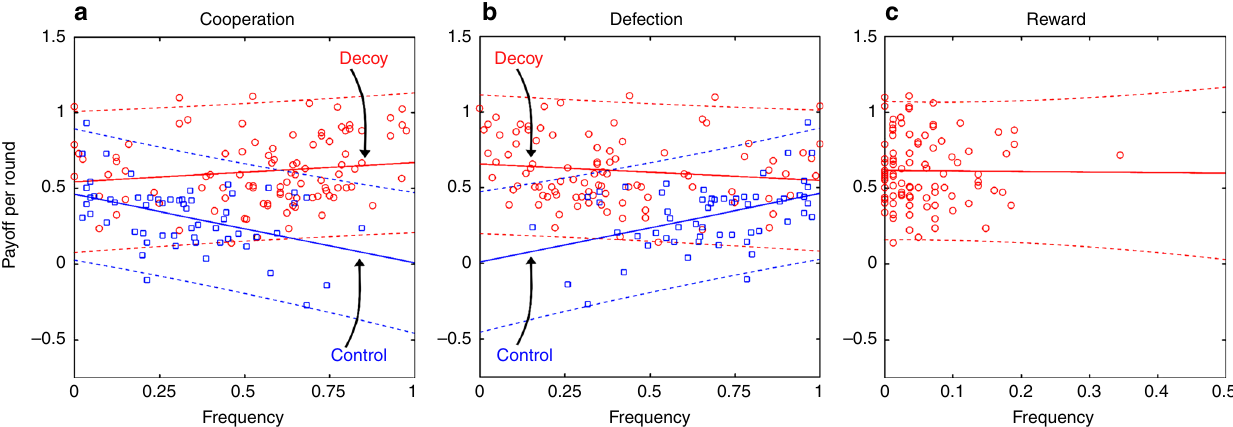
Fig. 5 Reward improves the likelihood of success for cooperators. a In the control treatment, per-round payoff correlates negatively with cooperation frequency (intercept 0.459, 95% con fi dence interval [0.369 – 0.549]; slope − 0.452, 95% con fi dence interval [ − 0.691 to − 0.212]; coef fi cient of determination R 2 = 0.197). This negative correlation disappears in the decoy treatment (intercept 0.541, 95% con fi dence interval [0.431 – 0.650]; slope 0.128, 95% con fi dence interval [ − 0.0511 to 0.306]; coef fi cient of determination R 2 = 0.0205). In fact, the angle between the two lines is signi fi cantly positive ( F -test for the treatment × frequency interaction; F -statistic 13.2; p value 0.0004), indicating that the decoy ’ s presence improves the likelihood of success for cooperators. b Because frequencies of cooperation and defection in the control treatment sum to unity, regression lines for cooperation and defection in this treatment must exhibit a mirror symmetry (intercept 0.0075, 95% con fi dence interval [ − 0.164 to 0.179]; slope 0.452, 95% con fi dence interval [0.212 – 0.691]; coef fi cient of determination R 2 = 0.197; cf. panel ( a )). Although the same symmetry need not hold in the decoy treatment due to reward, regression lines for cooperation and defection are also almost an ideal mirror image of one another (intercept 0.654, 95% con fi dence interval [0.575 – 0.733]; slope − 0.109, 95% con fi dence interval [ − 0.276 to 0.0577]; coef fi cient of determination R 2 = 0.0173; cf. panel ( a )), indicting that reward worsens the likelihood of success for defectors ( F -test for the treatment × frequency interaction; F -statistic 12.9; p value 0.0004). c Per-round payoff shows no correlation with the frequency of reward (intercept 0.614, 95% con fi dence interval [0.552 – 0.676]; slope − 0.0355, 95% con fi dence interval [ − 0.808 to 0.737]; coef fi cient of determination R 2 = 0.0083), thus explaining the mirror symmetry of regression lines for cooperation and defection in the decoy treatment. Solid lines represent the ordinary least squares regression, whereas dashed lines are the corresponding 95% prediction con fi dence